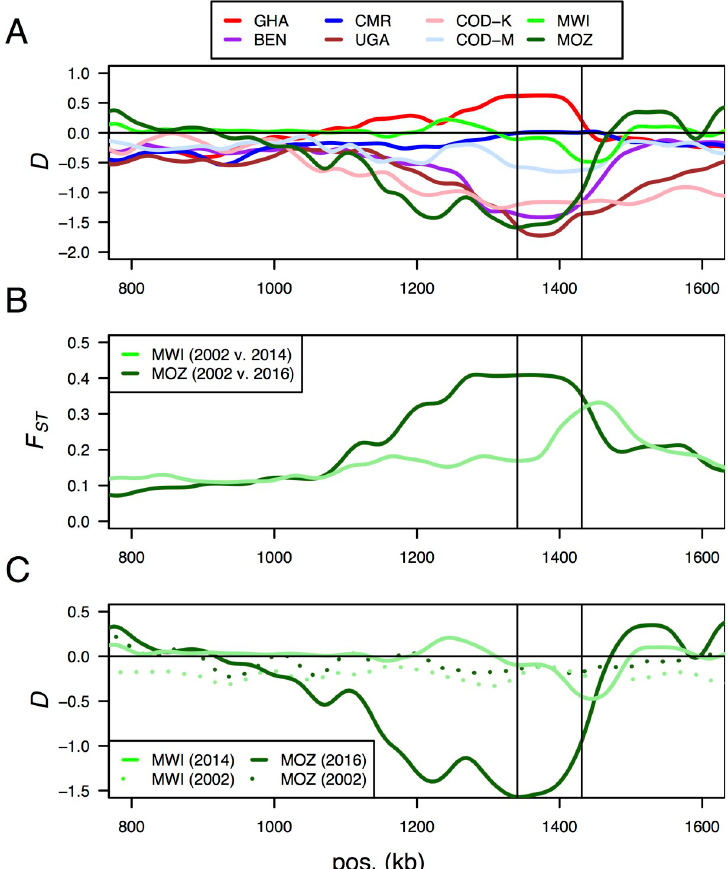
Fig 3. A selective sweep associated with insecticide resistance in An . funestus populations across Africa on chromosome arm 2R. (A) A selective sweep spanning a CYP6 gene cluster associated with pyrethroid resistance in Benin (BEN), Uganda (UGA), Kinshasa, DRC (COD-K), Mozambique (MOZ) and Malawi (MWI). Lines are kernel- smoothed Tajima’s D values calculated for 10 kb windows moving in steps of 5 kb. The vertical lines in all panels indicate the start and end of the CYP6 cluster. The sweep is less pronounced for Malawi, in part due to the complete fixation of reference alleles, and is clearer in the temporal analyses. (B) Temporal changes in allele frequencies at the CYP6 gene cluster in Malawi (light green) and Mozambique (dark green). Lines show kernel-smoothed F kb sliding window moving in 5 kb steps) between 2002 and 2014/2016 and show elevated F cluster (indicated by the vertical lines). (C) Temporal changes in Tajima’s D, showing that the peaks of high F ST are due to the loss of diversity (excesses of rare alleles, negative Tajima’s D) in the Malawi 2014 population (solid light green line) and the Mozambique 2016 population (solid dark green line), compared to the 2002 populations (dashed lines) which show no evidence of deviation from selective neutrality. Lines show kernel-smoothed Tajima’s D (for a 10 kb sliding window moving in 5 kb steps). Positions (‘pos’, in kb) refer to scaffold KB669169.